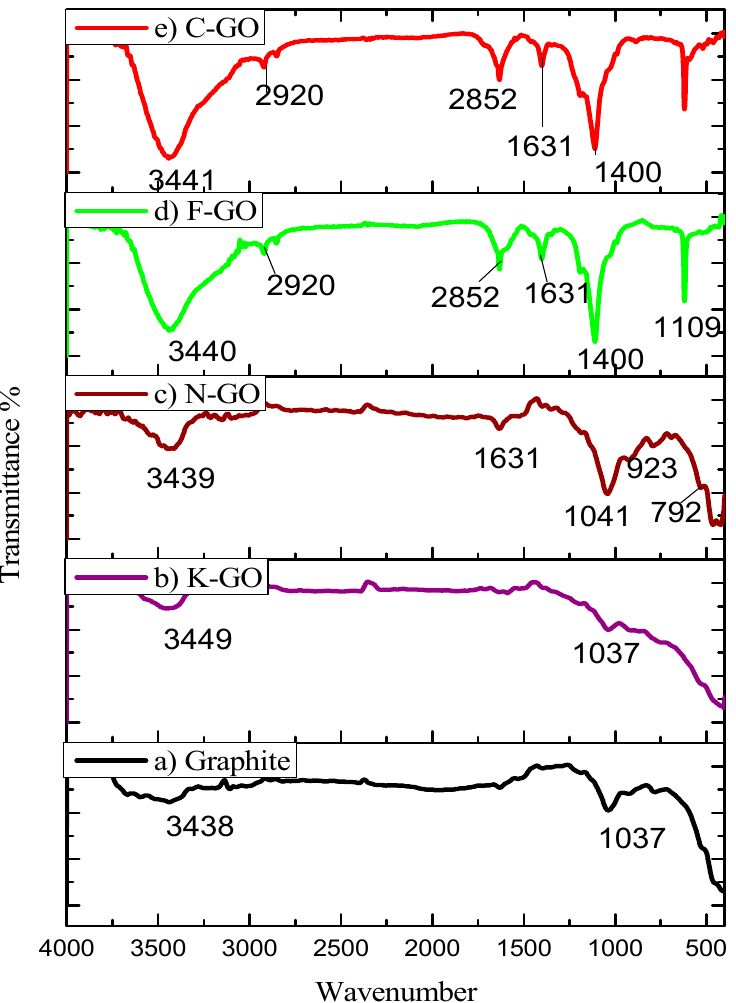
Figure 2. FTIR images of pristine graphite ( a ), K–GO ( b ), N–GO ( c ), F–GO ( d ), and C–GO ( e ).